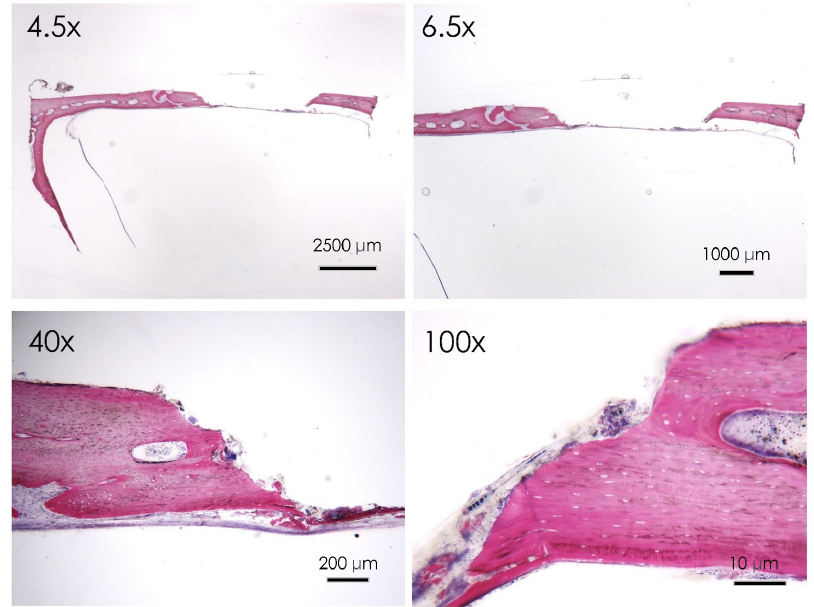
Figure 6. Control group. Histological section of the calvaria bone specimens at different magnifications (4.5×, 6.5×, 40×, and 100×). Evidence of surface bone resorption was evident at the level of the defect margin.